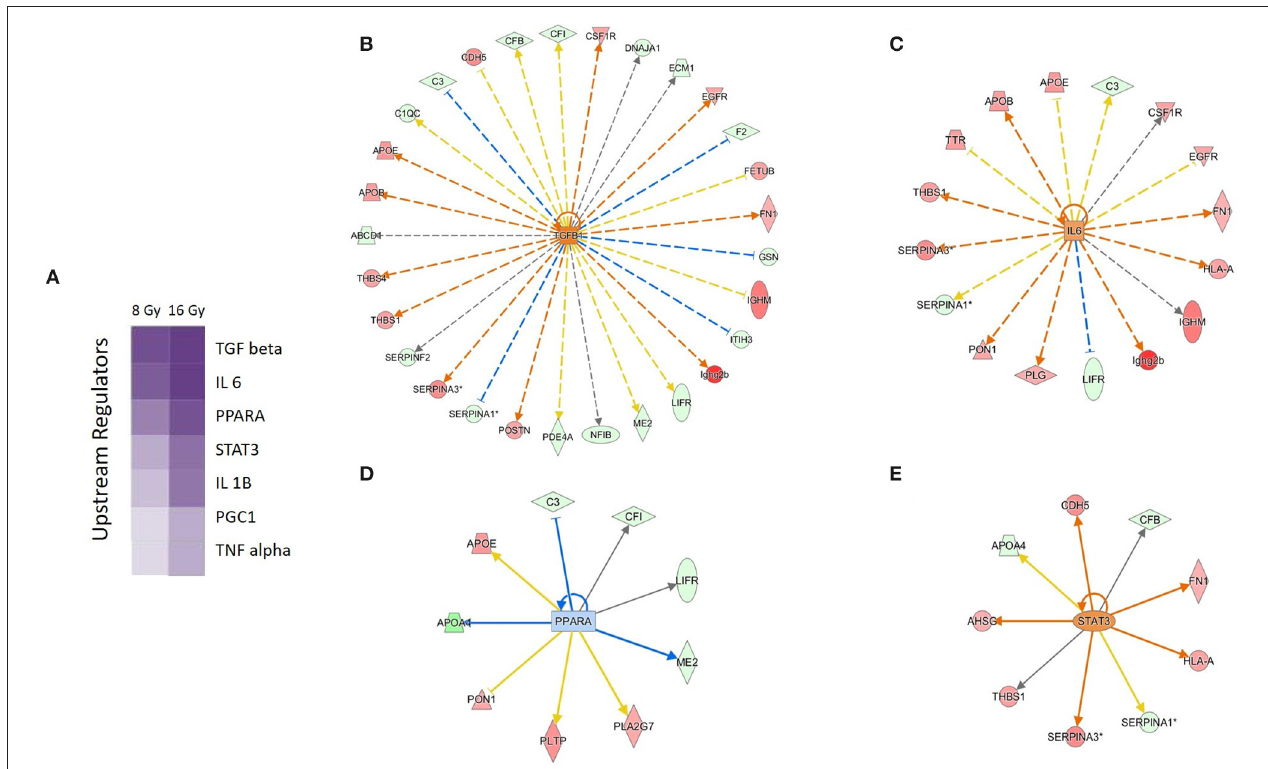
FIGURE 3 | Predicted upstream regulators of the deregulated serum proteins. Predicted upstream regulators are displayed using a purple color gradient where the intensity of the purple color corresponds to statistical significance (the deeper the color, the higher the significance). The score is the negative log of the p -value derived from Fisher’s exact test. By default, the rows (upstream regulators) with the highest total scores across the set of observations are sorted to the top (A) . The predicted upstream regulators and their activity status at 16Gy are shown: TGF- β (B) , IL-6 (C) , PPAR α (D) , and STAT3 (E) . The orange and the blue color of the nodes indicate activation and deactivation, respectively; the solid arrows represent direct interactions and the dotted arrows indirect interactions. The deregulated proteins forming the wheel around the nodes are marked in red (upregulation) and green (downregulation). The IPA codes and corresponding full protein names are shown in Table 1 and in Supplementary Table 1 . The analysis was performed using Ingenuity Pathway Analysis (IPA) (https://www.qiagenbioinformatics.com/